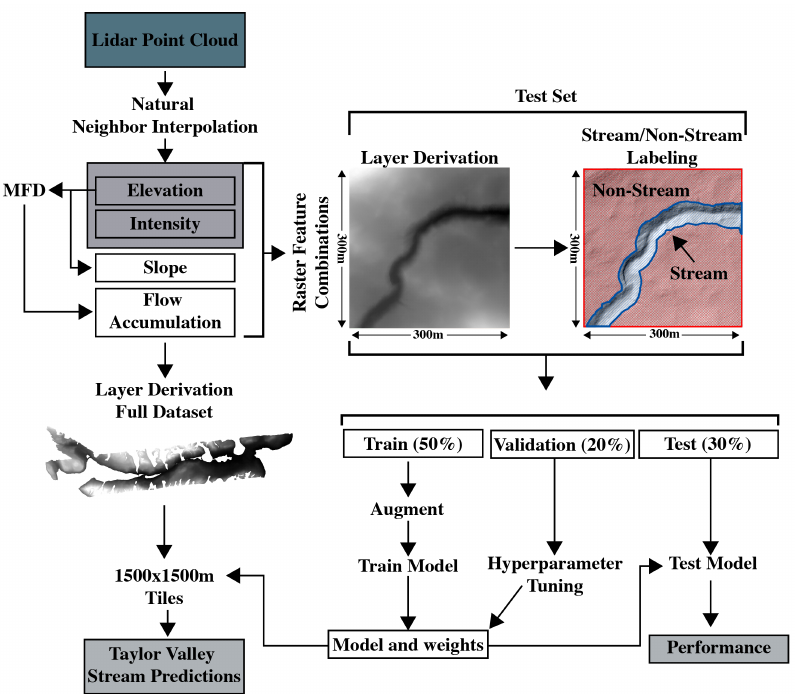
Figure 4. Flow chart of the proposed semi-autonomous stream and boundary